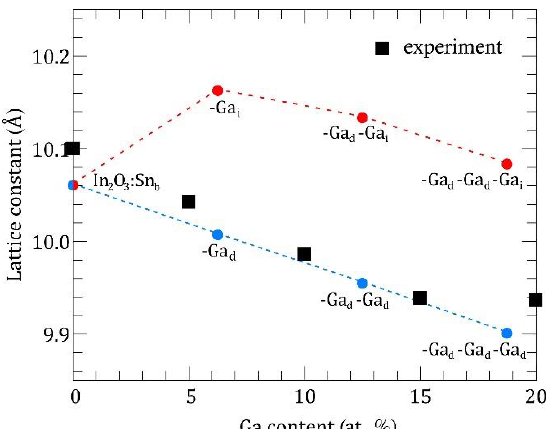
Figure 6. Lattice constant of ITO:Ga as a function of Ga content. Squares denote XRD data. Red and blue circles denote theoretical calculations with Ga atoms placed in different positions (interstitial c -site and substitutional d -site).